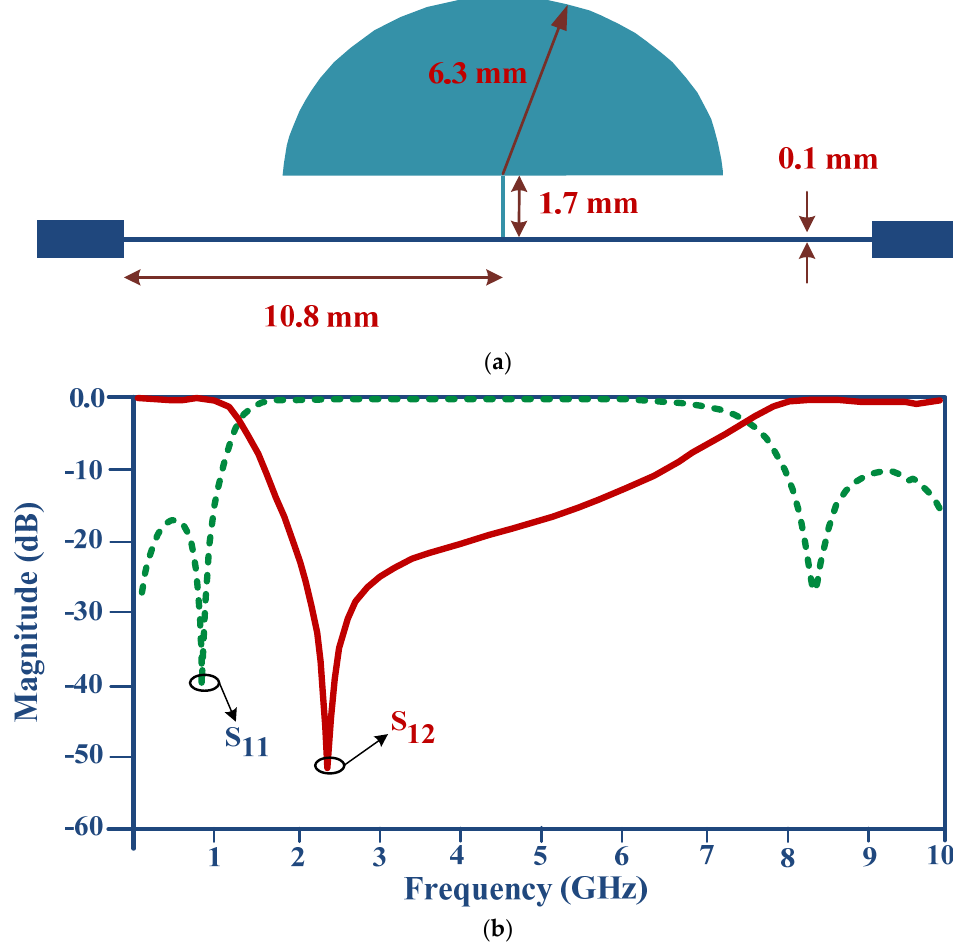
Figure 3. The half-elliptical shaped resonator ( a ) structure and ( b ) its frequency response. The half-elliptical shaped resonator and the rectangular resonator are shown in Figure 4. A new length “L” is calculated in Equation (3) and used to calculate the LCE circuit of the half-elliptical resonator. The “a” and “b” are the diameters of the half-elliptical shape. The semi-elliptical area is calculated in Equation (1), and the area of the